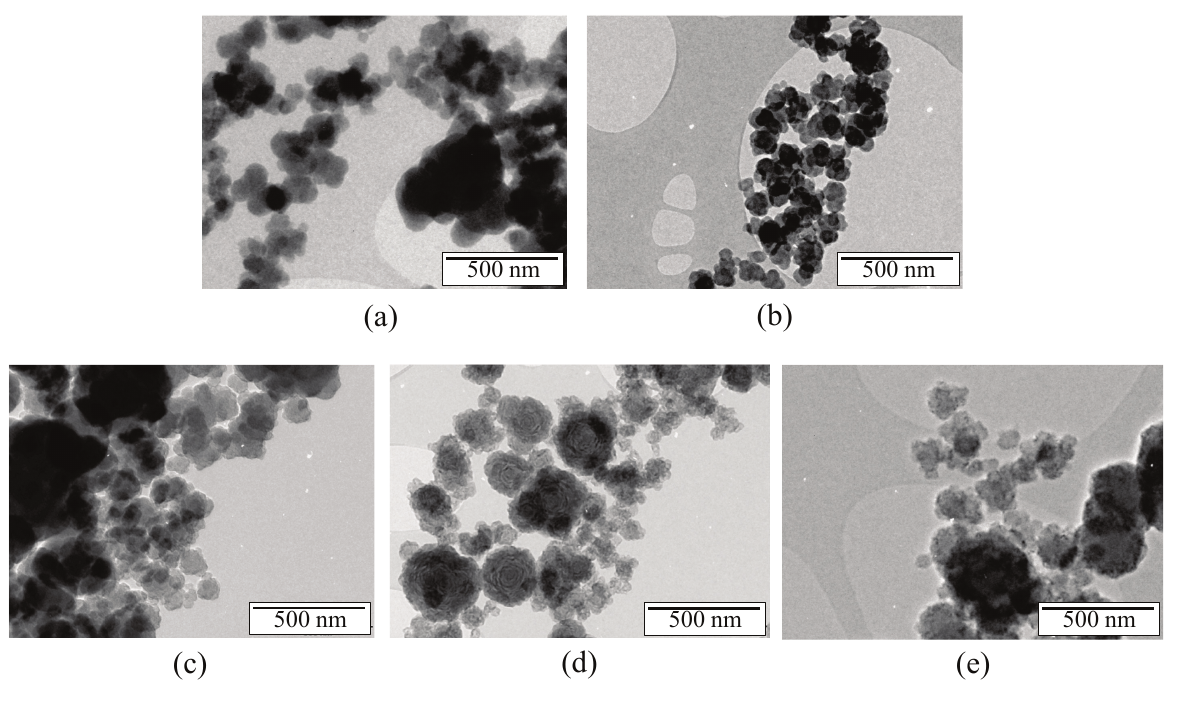
Figure 4. TEM images of the samples annealed at ( a ) 1450 °C; ( b ) 1600 °C; ( c ) 1700 °C; ( d ) 1800 °C and ( e ) 2000 °C.